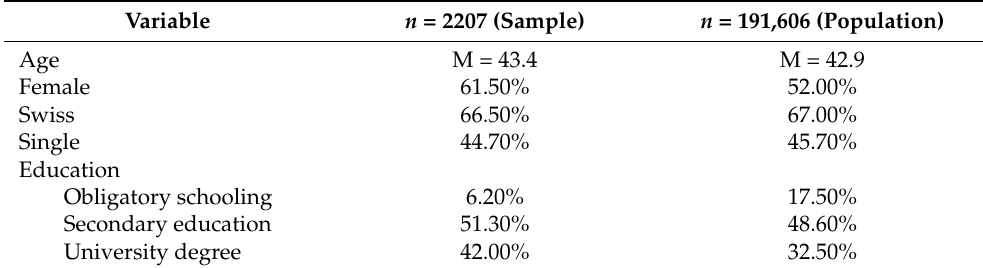
Table 1. Comparing the characteristics of the sample with the actual population in Basel-City in 2013.